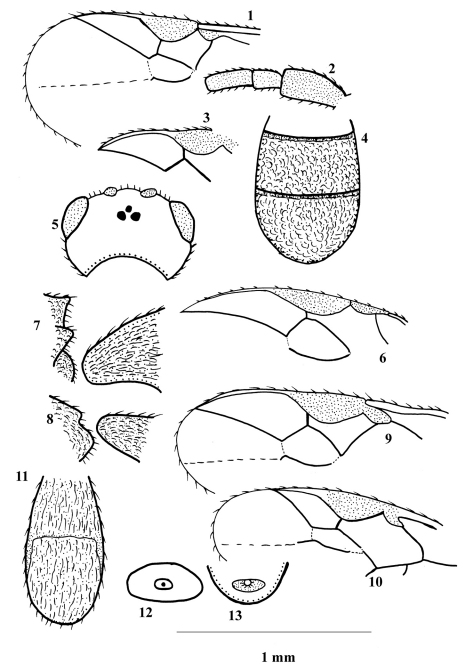
1, 2
Phanerotoma masiana
3–5
Phanerotoma dentata
6
Phanerotoma henedecasisella
7
Ascogaster quadridentata
8
Ascogaster excisa
9
Phanerotoma leucobasis
10–12
Chelonus basalis (after Lozan and Tobias 2002) 13
Chelonus sulcatus. 1,3,6,9,10, part of fore wing (1.6 × scale line, 3.4 ×, 5.3 ×, 2.9 ×,1.9 × ); 2, basal flagellomeres (1.0 ×); 4,11, dorsal aspect of carapace (2.7 ×, 1.8 ×); 5, dorsalaspect of head (2.8 ×); 7,8, lateral aspect of propodeum (2.6 ×, id.); 12,13, apical aperture (1.8 ×, 2.2 ×).